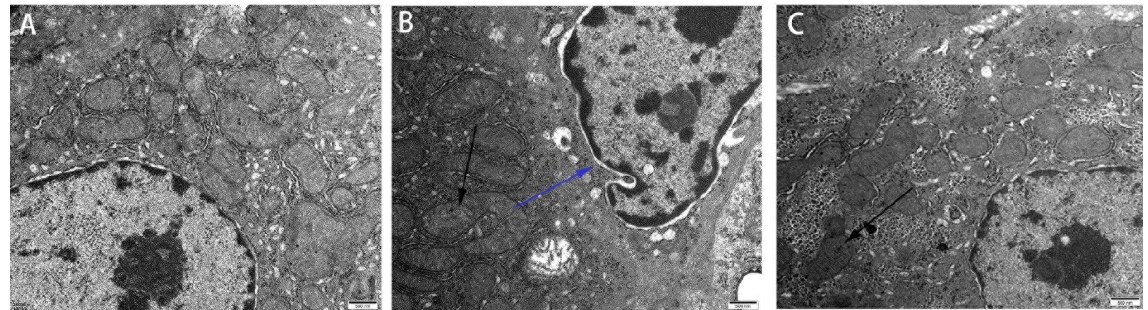
Figure 2. Effect of Res on the ultrastructure of liver of duck liver exposed to AFB1 (500 nm). ( A ) the control group; ( B ) the AFB1 group; ( C ) the AFB1 + Res group. The blue arrowheads indicate the damage to hepatocyte nuclear membrane, the black arrowheads indicate mitochondria swollen irregularly and their cristae fractured and fuzzy.